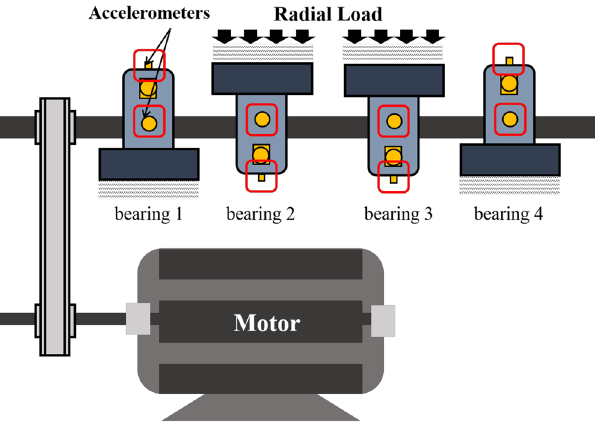
Figure 4. Installation diagram of bearings and sensors on IMS.